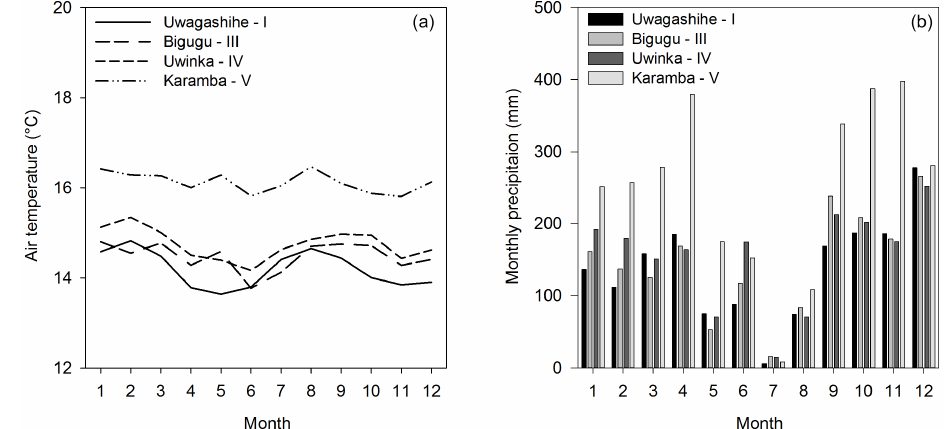
Figure 1. Seasonal variation of monthly mean air temperature (a) and monthly precipitation (b) at four meteorology stations located across a 32km east–west transect in Nyungwe tropical montane forest. Roman numbers refer to locations presented in Table 1. The data are based on half-hourly measurements from July 2013 to June